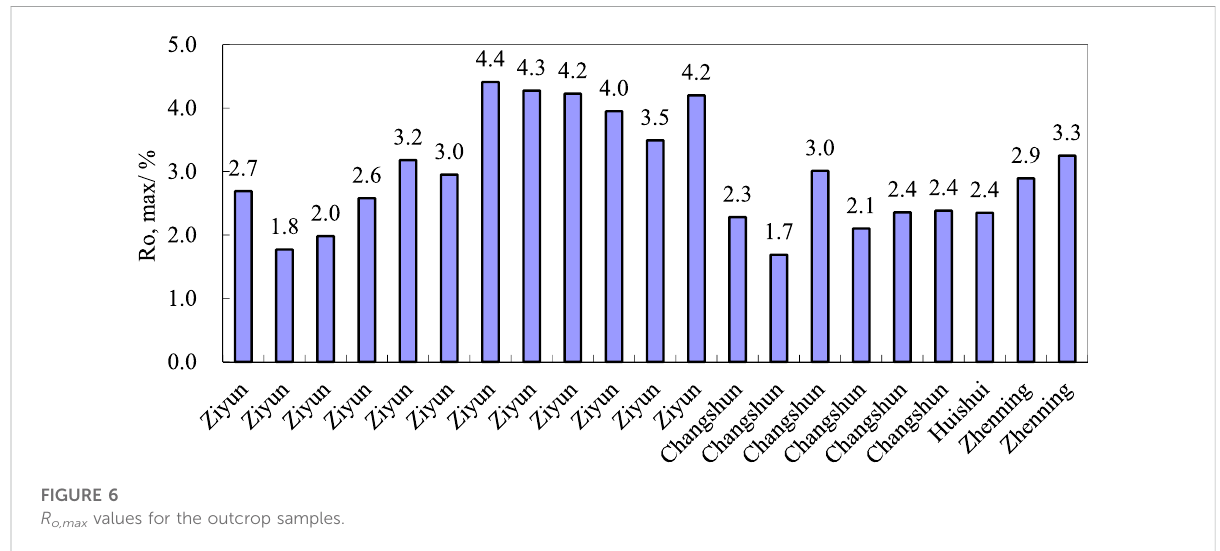
FIGURE 6 R o,max values for the outcrop